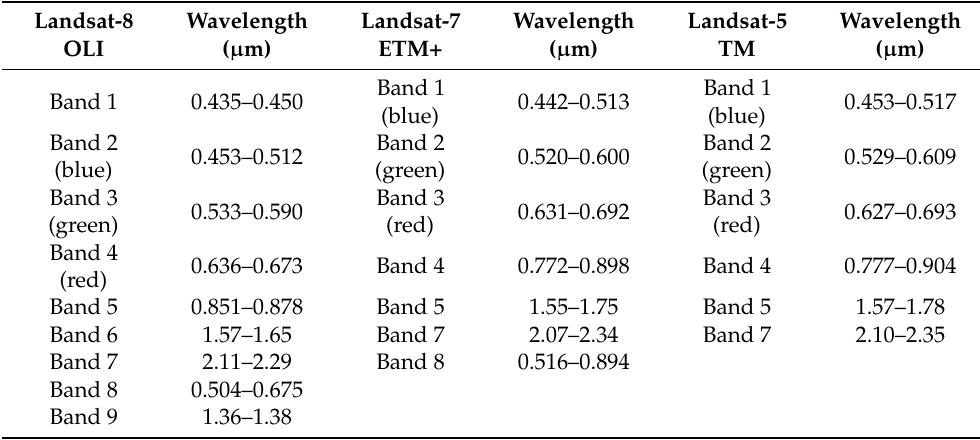
Table 1. The spectra of the three Landsat TM, ETM+, and OLI sensors (band setting is from